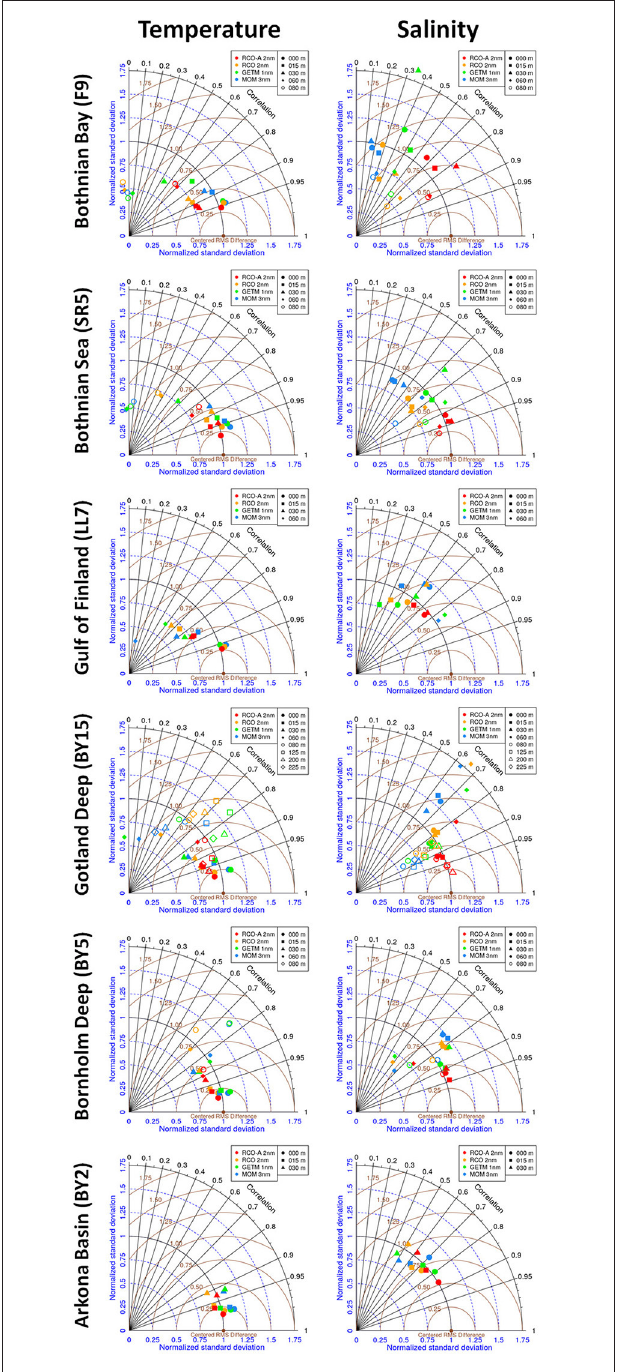
FIGURE 5 | Taylor diagrams derived from monthly time series of sea temperature ( left ) and salinity ( right ) from 1970 to 1999 at particular standard depths at BY2 in the Arkona Basin, BY5 at Bornholm Deep, BY15 at Gotland Deep, LL7 in the Gulf of Finland, SR5 in the Bothnian Sea, and F9 in the Bothnian Bay. Correlation, normalized standard deviation, and centered RMS difference of the simulated time series from the ocean models RCO-A (red), RCO (orange), GETM (green), and MOM (blue) compared to the BED observation data are shown. Different plotting symbols refer to the single depths. See text for more